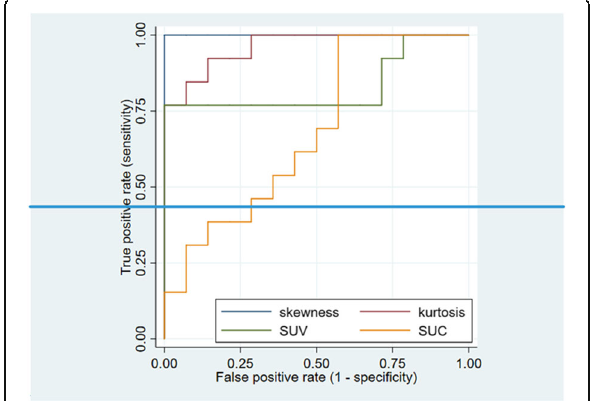
Fig. 4 The empirical ROC curve of the four investigated imaging